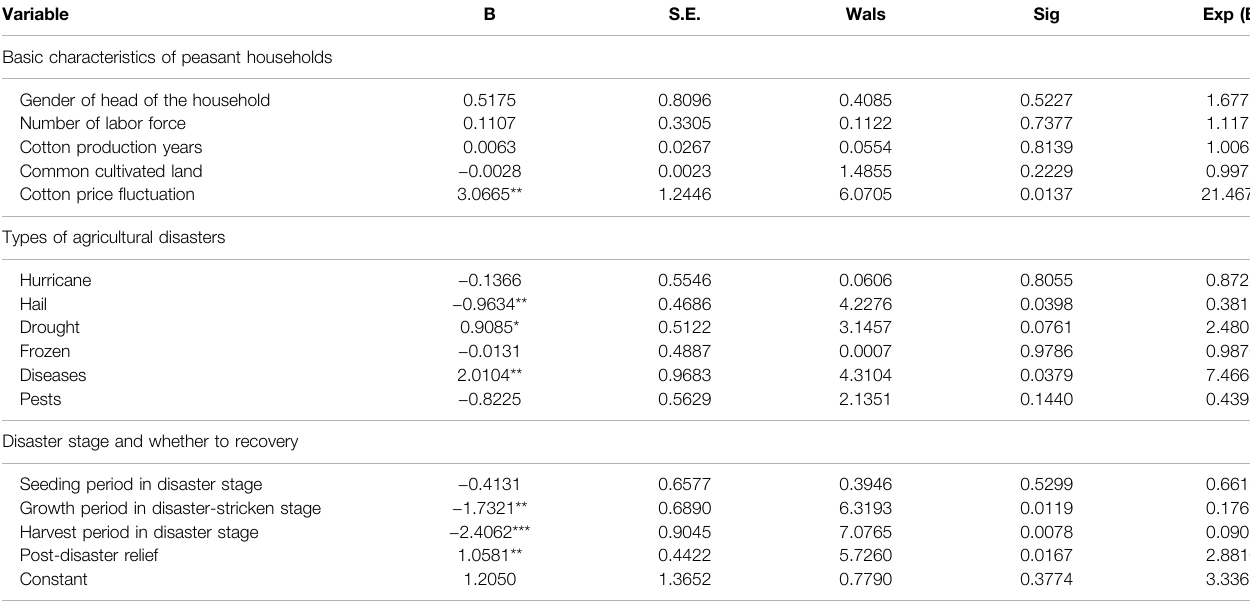
TABLE 5 | Estimation results of binary logistic model. Variable